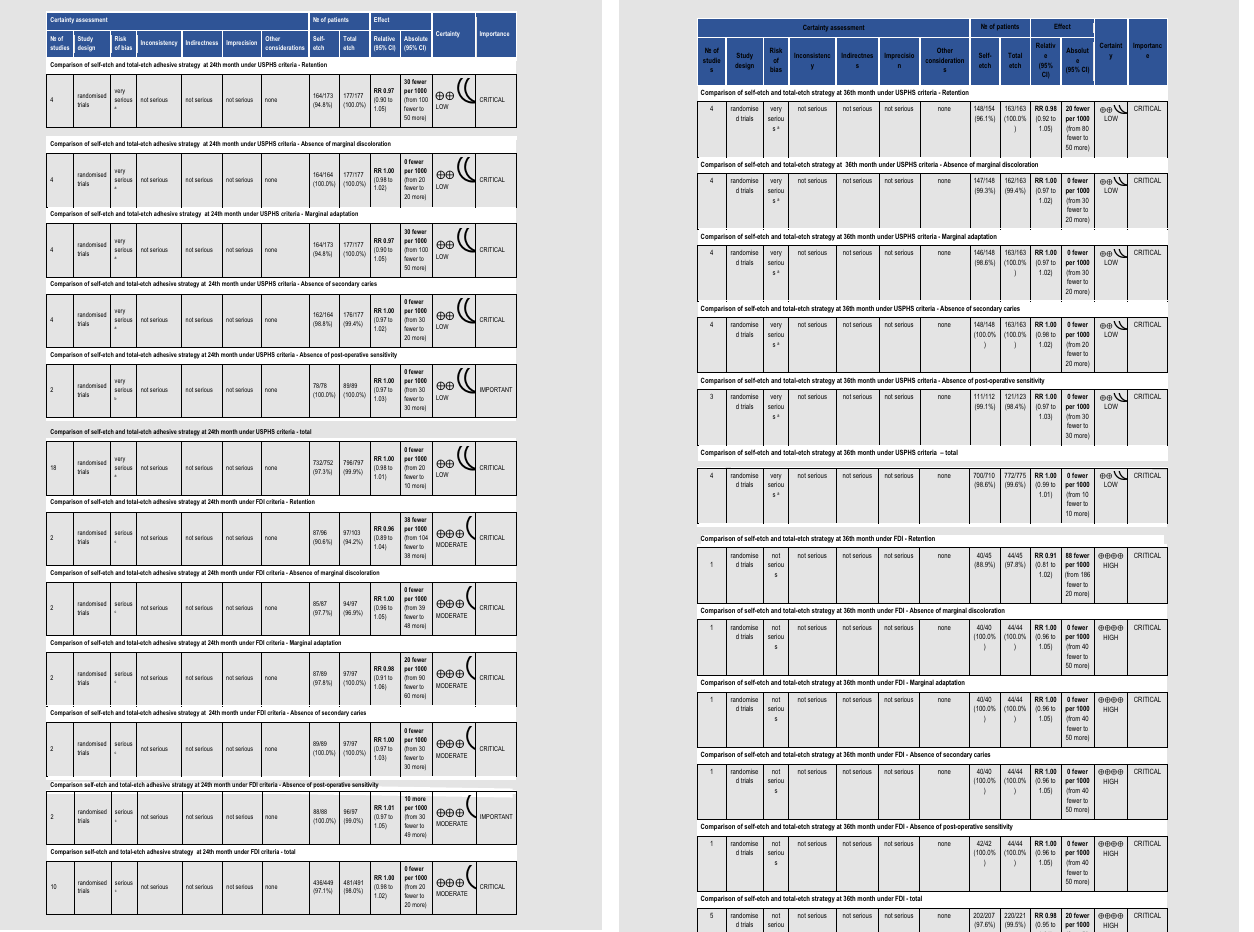
Table 5. GRADEpro assessment of certainty of evidence at 24 month follow-up using FDI and USPHS criteria.